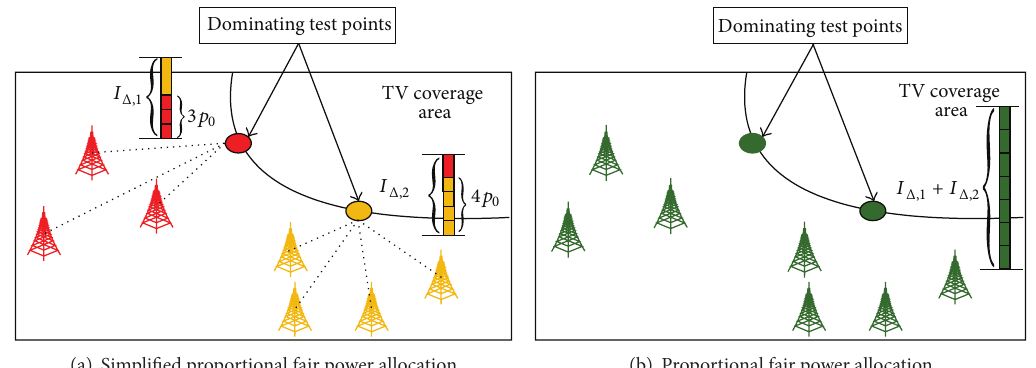
Figure 1: Comparison of simplified PF and PF power allocation